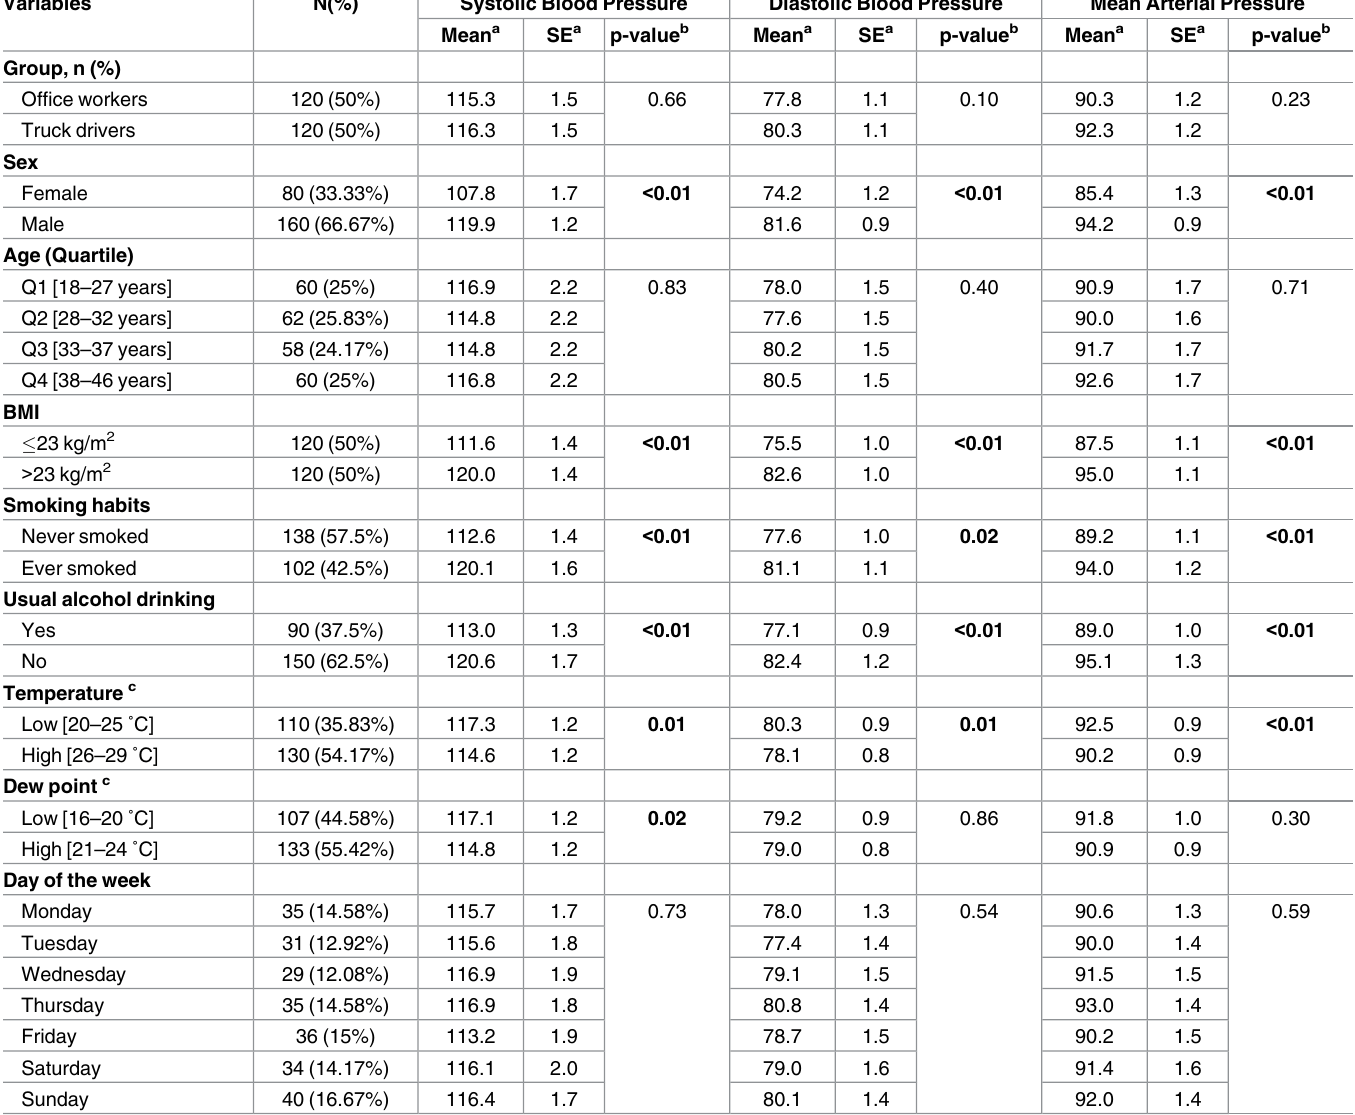
a Means and standard error of blood pressure and heart rate measured on two examination days were estimated by marginal means and corresponding standard error from mixed-effects regression models. b p-values were calculated using mixed-effects regression models.